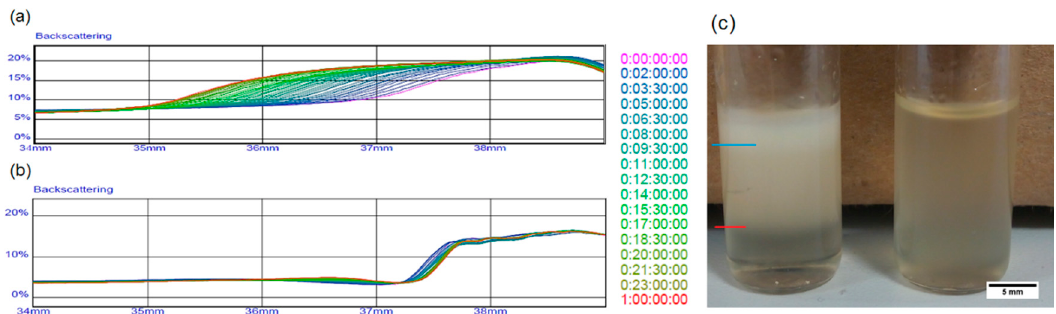
Figure 2. Stability comparison of emulsions in liquid state through backscattering analysis of ( a ) the sample without maltose and ( b ) the sample with maltose; ( c ) Comparison between emulsions one week after their preparation. The blue line in the figure indicates the level of water separated from the emulsion, while the red line marks a region deprived of water microdroplets.